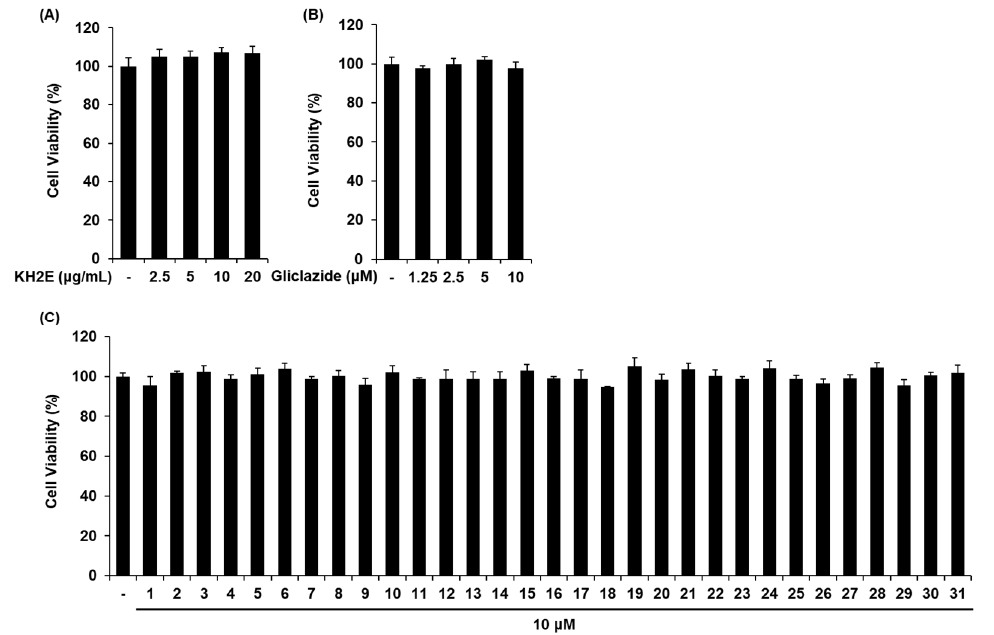
Figure 4. E ff ects of KH2E and compounds 1 – 31 on cell viability in INS-1 cells. Results of MTT assay for viability of INS-1 cells after 24 h of treatment with ( A ) KH2E, ( B ) gliclazide, and ( C ) compounds 1 – 31 when compared with the untreated control. Data represent the mean ± standard error of the mean (S.E.M.), n = 3.